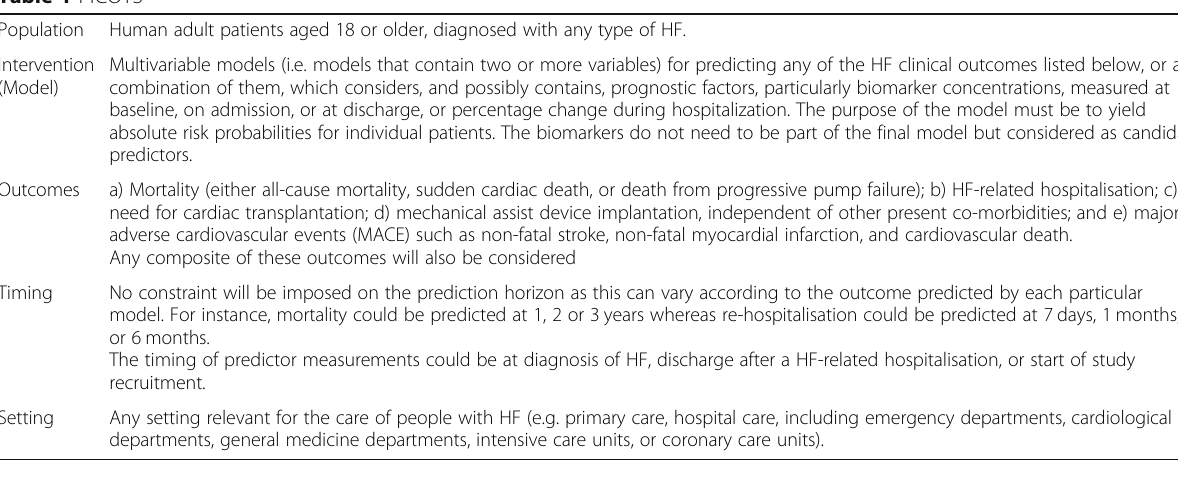
Table 2 lists the inclusion and exclusion criteria,